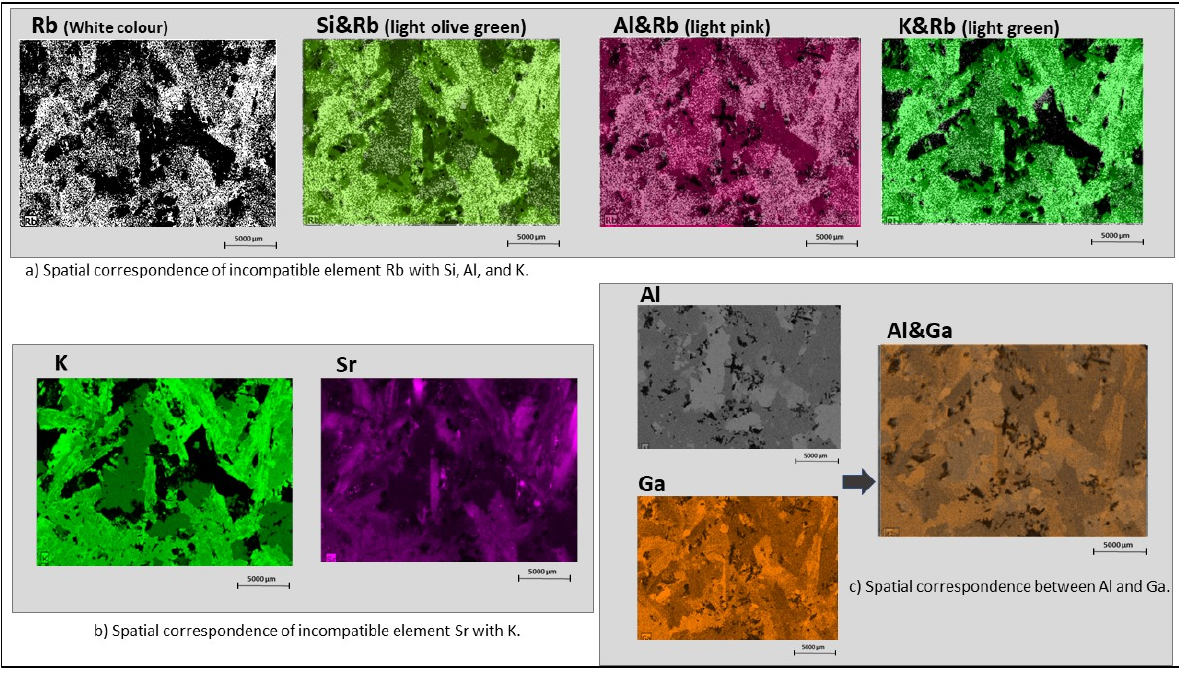
Figure 4. Spatial distribution and correspondence between ( a ) Rb and Si, Al, and K, ( b ) Sr and K, and ( c ) Ga and Al.